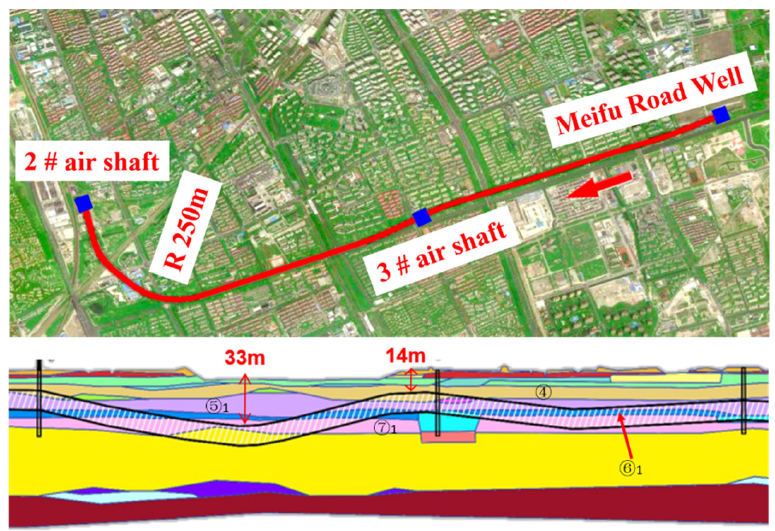
Figure 1. Longitudinal profile of excavation soil layer in synchronous propulsion and assembly mode.